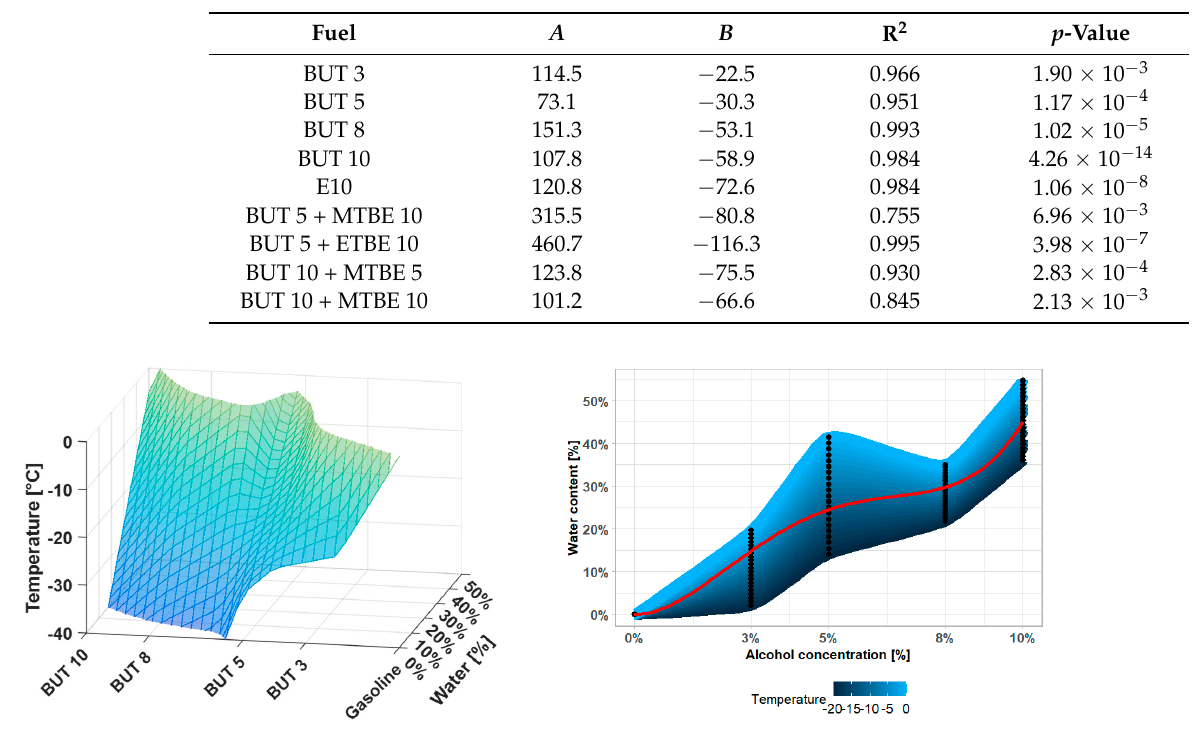
Table 3. Parameters A and B of the linear equation T = Aw + B depicted in Figure 7, correlation coefficients, R 2 , and p -value for each fit of water solubility of fuel mixtures.